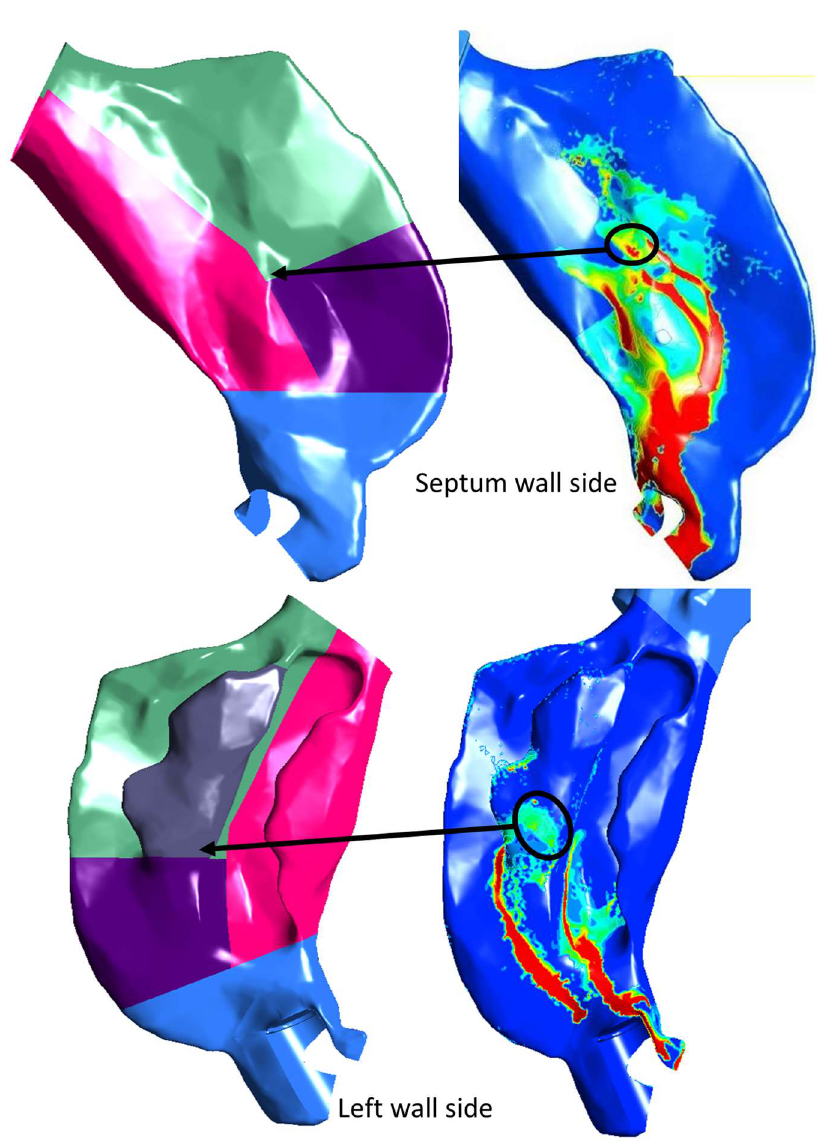
Figure 9. Specific posterior nasal regions and the corresponding spray liquid mass deposition predicted by the SWI-PDLM model on the nasal septum wall (upper image panel) and left-side outer wall (lower image panel).